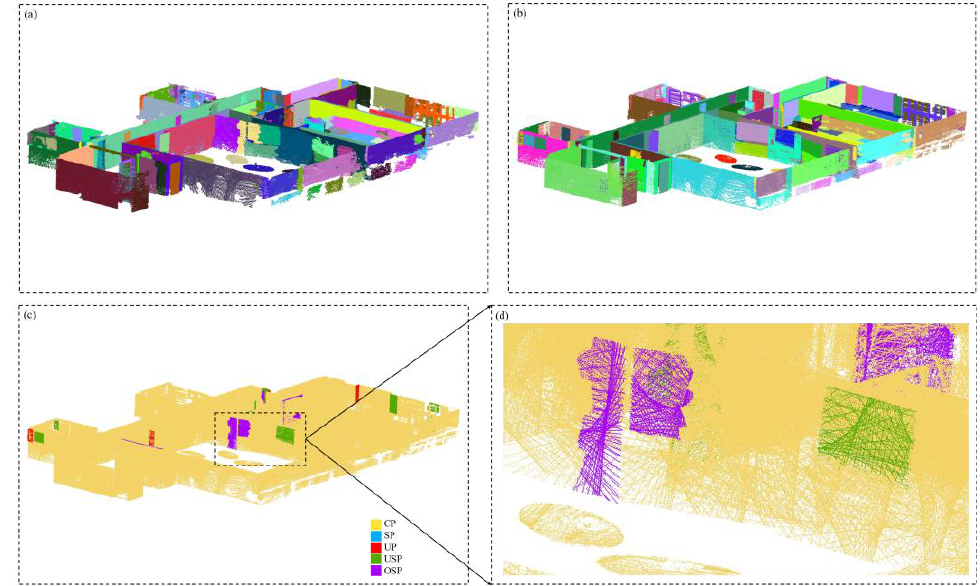
Figure 14. Plane-segmentation results for the TUB2 dataset: ( a ) proposed method, ( b ) ground truth, ( c ) the main differences between ( a ) and ( b ), and ( d ) enlarged part.